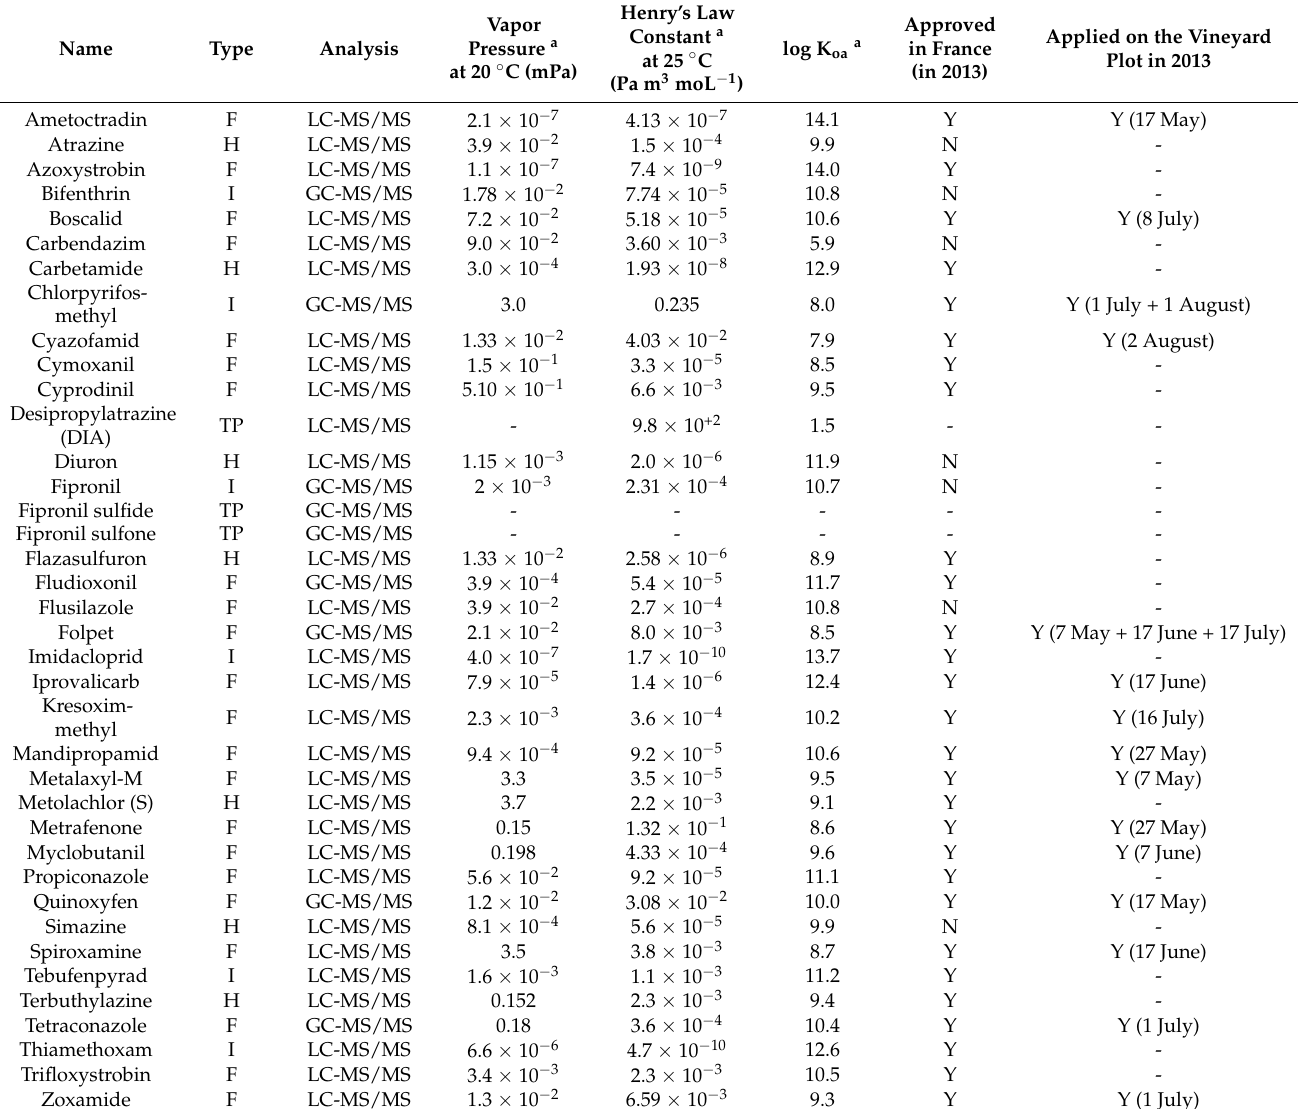
Table 1. Use and physicochemical properties of the pesticides investigated in this